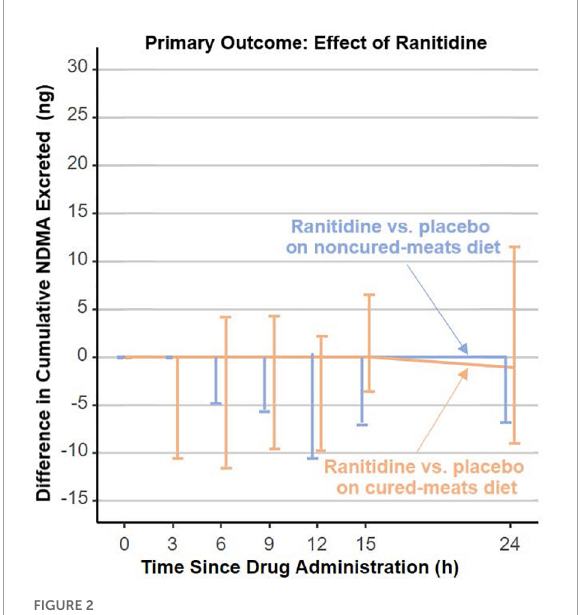
FIGURE2 Division of applied regulatory science (DARS) designed a rigorous clinical study that carefully controlled for factors known to influence N -nitrosodimethylamine (NDMA) measurements including diet. The study found no evidence of increased NDMA content in participants’ urine who were administered ranitidine